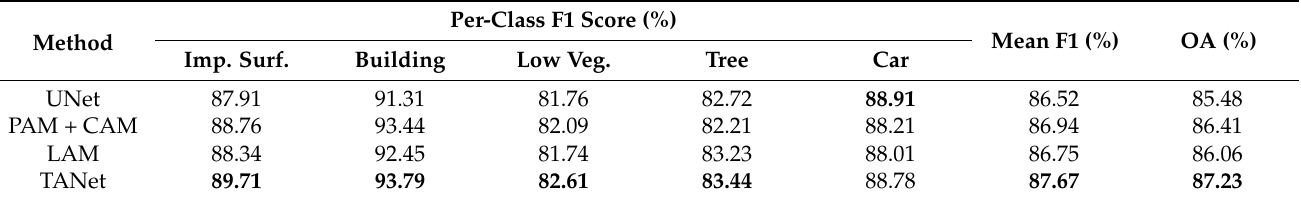
Table 1. F1 score, Mean F1, and OA index results of multi-object on Potsdam dataset.